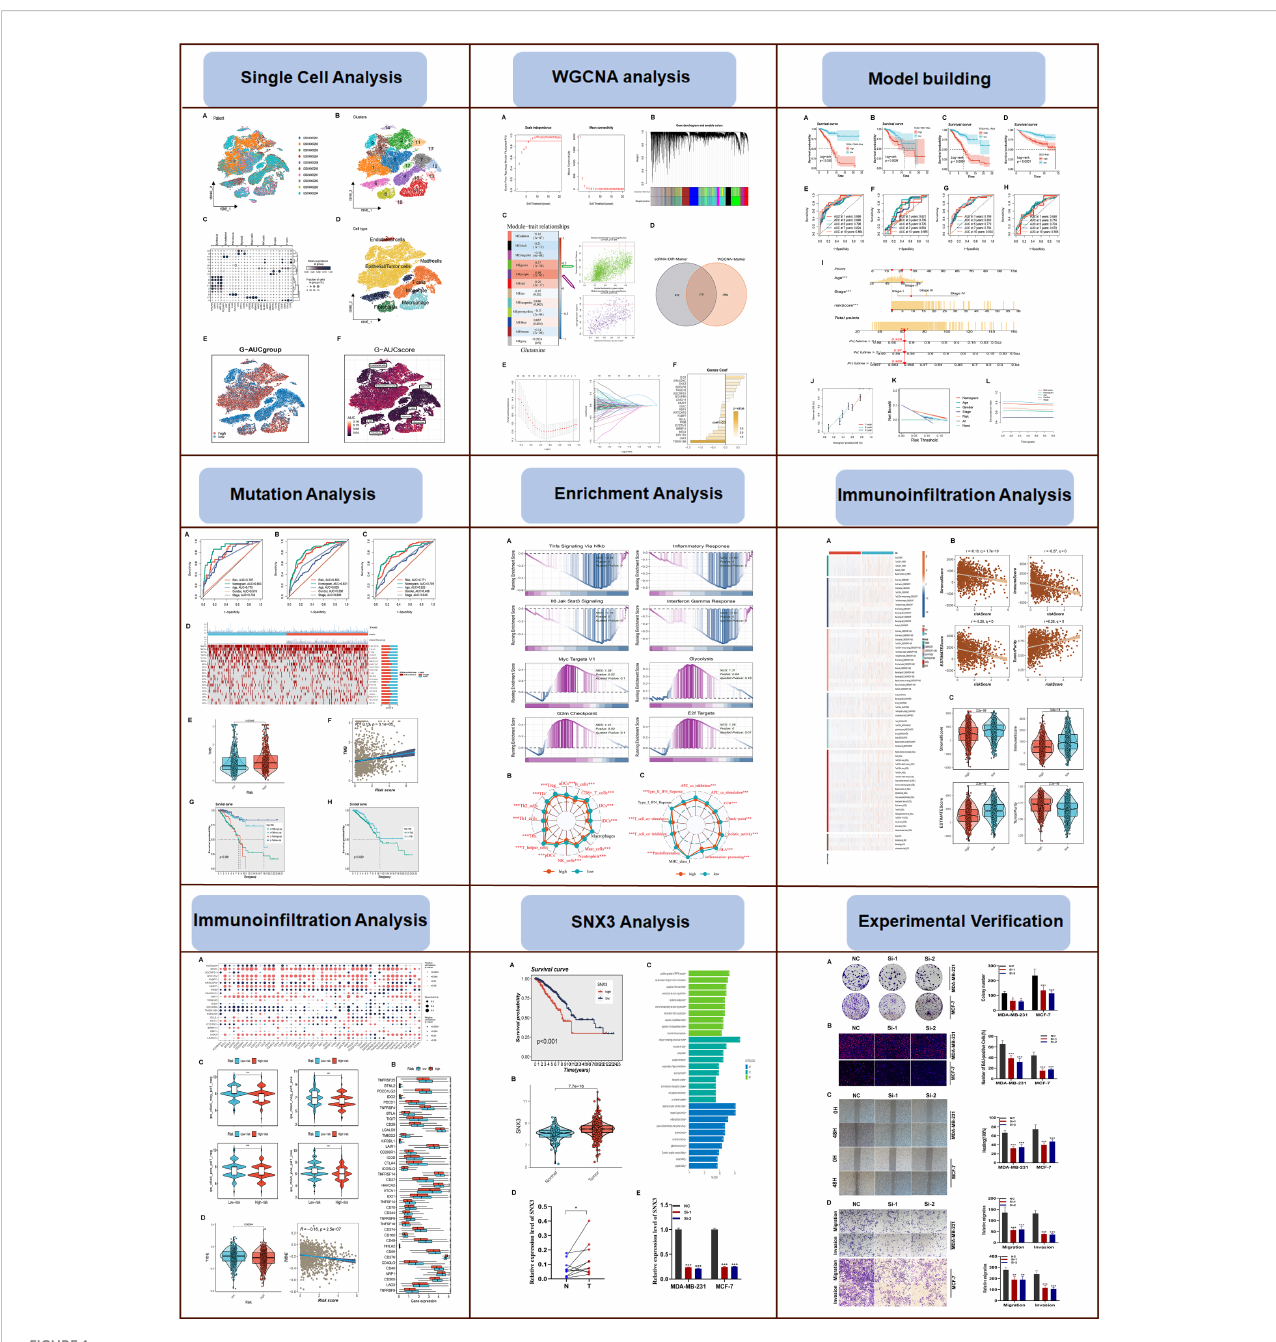
FIGURE 1 The fl owchart of this